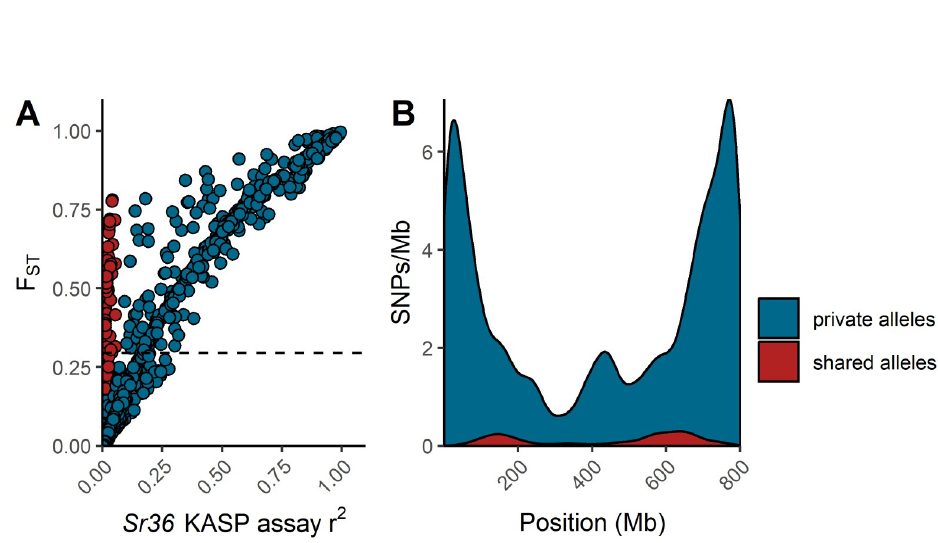
Fig 3. Genome-wide F ST scan. F ST values were estimated for each SNP in the A genome (top row), B genome (middle row), and D genome (bottom row). The dashed line signifies the 99 th percentile of F values for all SNPs. ST